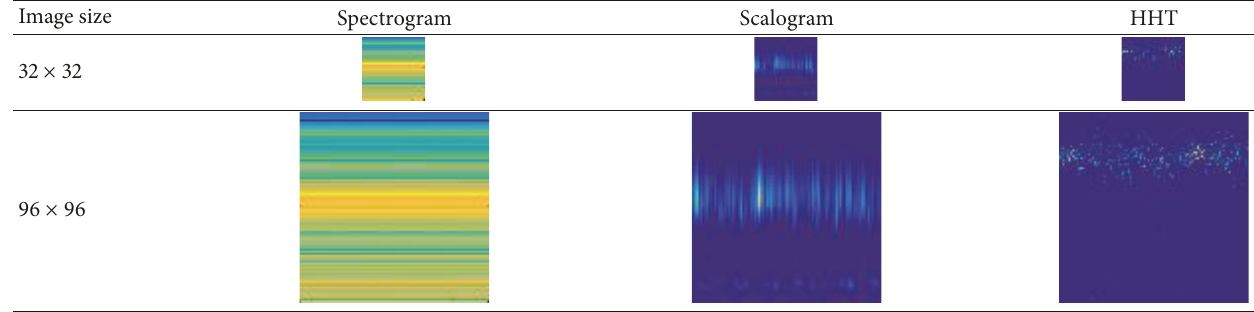
Table 16: CWR ball fault images.